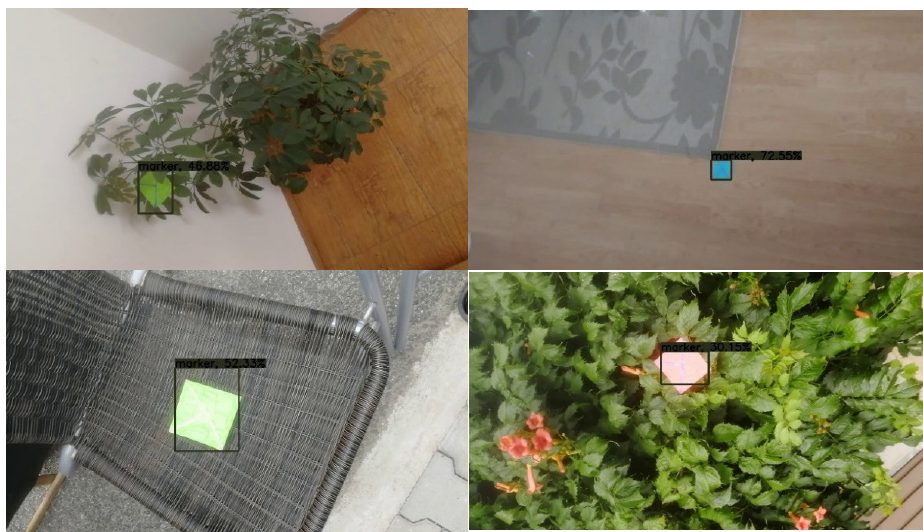
Figure 21. Examples of detected markers that were manually drawn. Two top images are taken in an inside environment, and two bottom images were taken outside.